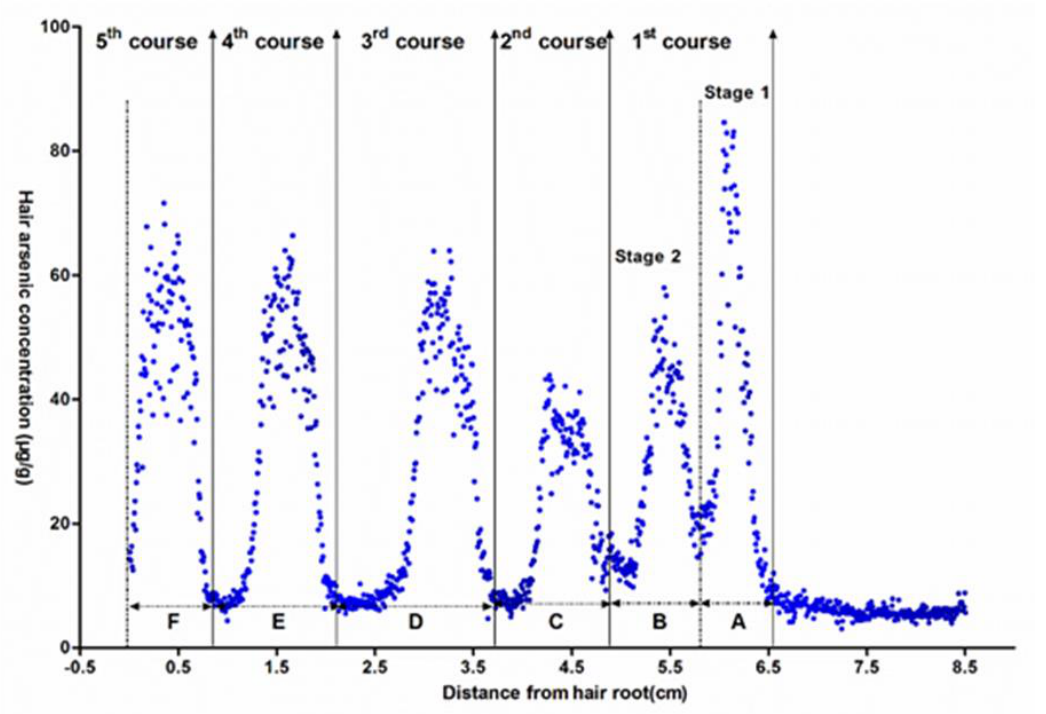
Figure 3. Arsenic concentration profiles for patient No. 8, A-F represents the interval between adjacent sessions.